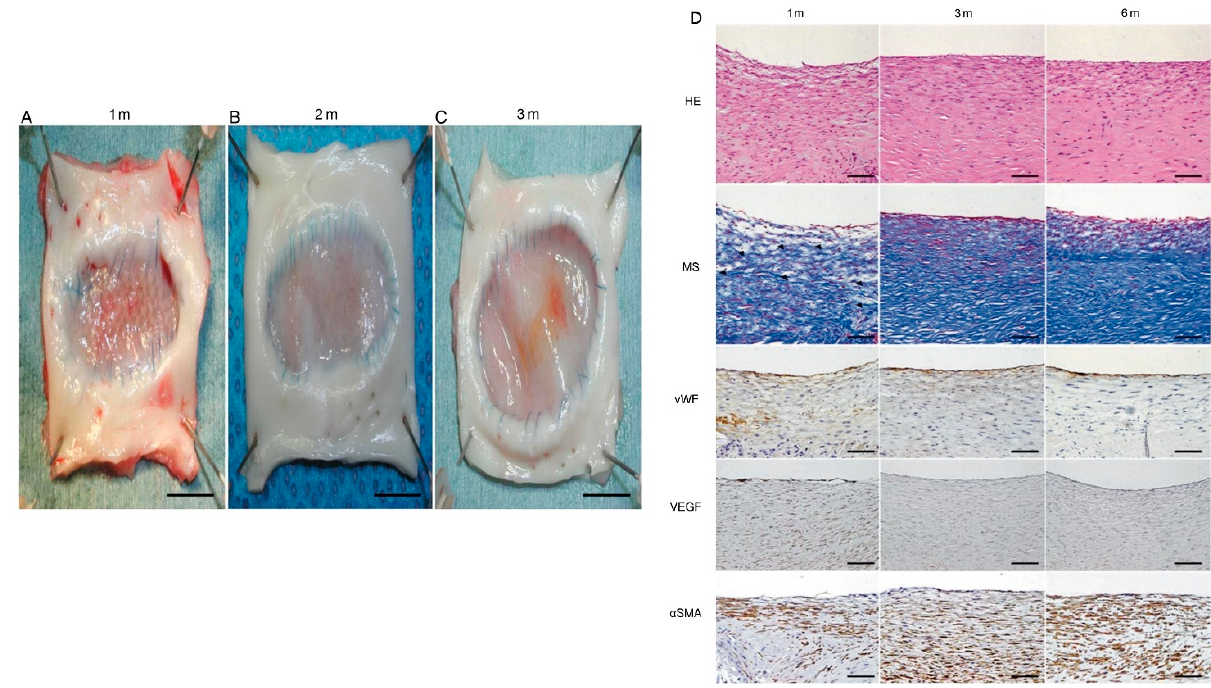
Figure 2. Data originally from Ichihara et al. 2015 demonstrating the macroscopic and histologic evaluation of a tissue- engineered arterial patch (TEAP) [78]. Macroscopic findings of each explanted tissue-engineered arterial patch at 1 month ( A ), 3 months ( B ) and 6 months ( C ) after implantation, showing no intimal hyperplasia and no aneurysm formation. No thrombus was observed. All inner sides of the patch were covered with native intima-like tissue with a smooth surface. Scale bar, 10 mm. ( D ) Hematoxylin–eosin (HE) and Masson staining (MS) at each observation end-point of bioabsorbable aortic patch. White and blank spaces (residual sponge polymer, arrowhead), which were observed in the TEAP at 1 month, were occupied by cellular components (red) and extracellular matrices (blue) in MS at 3 and 6 months after implantation. These findings showed good cell and tissue proliferation in the TEAP over time. Immunohistochemical staining for vWF, VEGF and α SMA (lower) is also shown. The luminal surfaces of the TEAPs were covered with a single layer of endothelial cells stained with antibodies to vWF at 1 month. The vWF-positive cells accumulated more clearly on the luminal surfaces of TEAP at 6 months. VEGF-positive cells in the patches were observed more on both the luminal surfaces and within the media 1 month after implantation; however, no VEGF expression was detected at 3 and 6 months. α SMA-positive cells were observed in the media of the regenerated tissue, and gradually increased over time. Original magnification HE, MS, vWF and α SMA ×200, VEGF ×100; scale bar, 100 μ m. HE: haematoxylin–eosin; MS: Masson staining; TEAPs: tissue-engi- neered arterial patches; vWF: von Willebrand factor; VEGF: vascular endothelial growth factor; α SMA: alpha-smooth muscle actin.